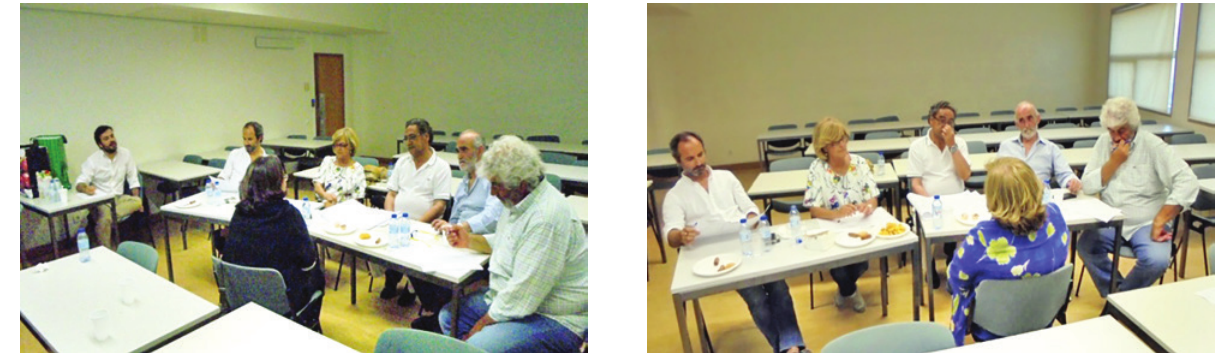
Figure 7. Snapshots of the Alphas’ interviews